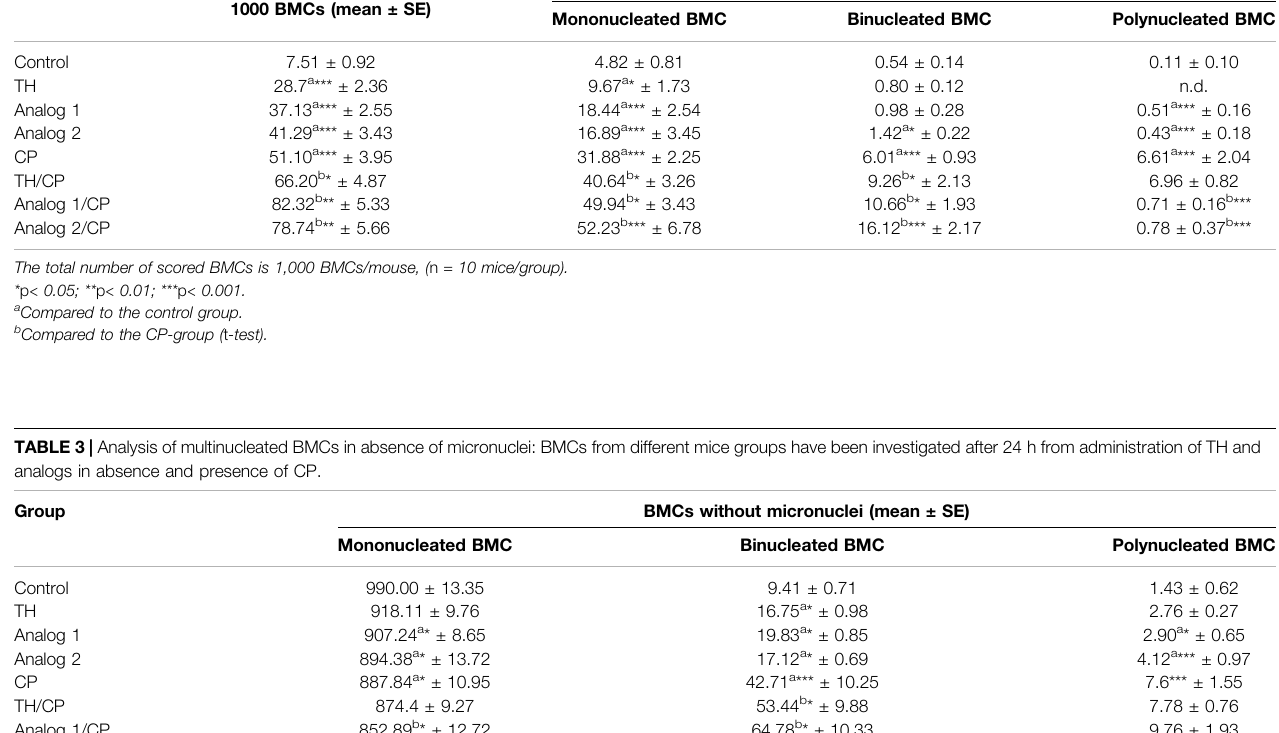
TABLE 2 | Micronuclei analysis: BMCs from different mice groups have been investigated after 24 h from administration of TH and analogs in absence and presence of CP. Group